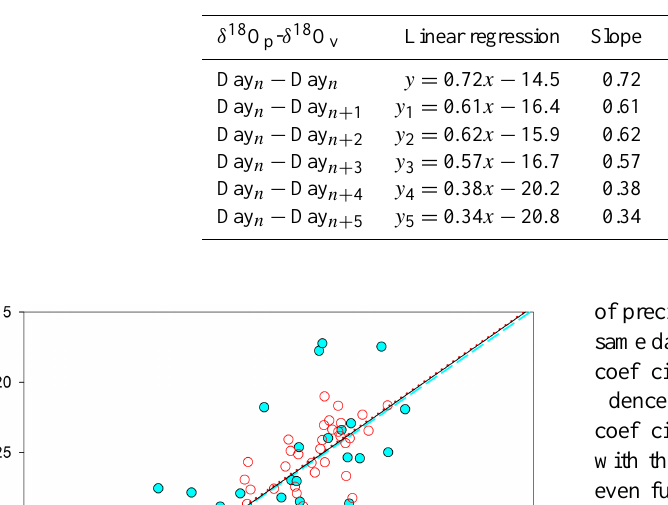
Table 1. Correlations between δ 18 O p and δ 18 O v at Nagqu. The x and y represent δ 18 O p and δ 18 O v on the same day (Day n ) , and the y 1 , y 2 , y 3 , ..., and y 5 represent δ 18 O v in the following first day (Day n + 1 ), ... (Day n + 2 ) , ... (Day n + 3 ) , ..., and the following fifth day (Day n + 5 ) , respectively.